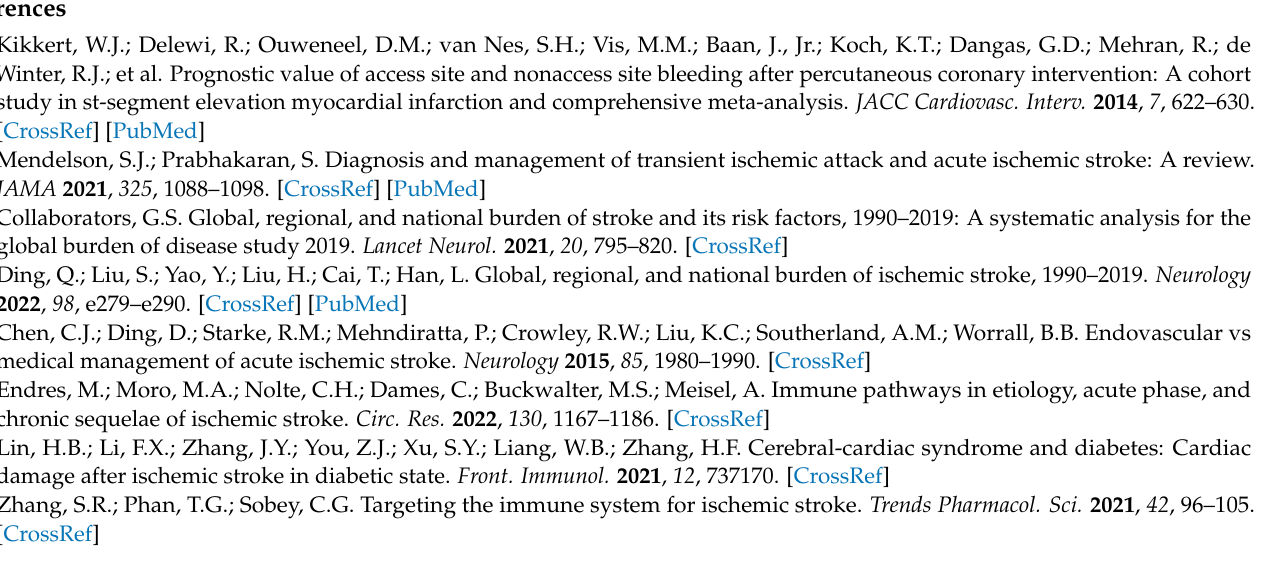
stain; Figure S2: Infarct volume of ischemic area; Table S1: Triphenyltetrazolium chloride staining ( n = 5); Table S2: Neurological deflict score ( n = 9); Table S3: Body weight ( n = 7–8); Table S4: The counts of exhaustion ( n = 6); Table S5: Moving distance ( n = 5–6); Table S6: Pull strength ( n = 6–9); Table S7: Muscle electrical signal intensity (n=4–5); Table S8: Soleus weight and soleus length ( n = 5); Table S9: Muscle cross section ( n = 5–6); Table S10: Sarcomere length ( n = 44–47); Table S11: JC-1 ratio of red to green fluorescence ( n = 4–6); Table S12: The protein expression of Drp1 and mitofusin 2 ( n = 5); Table S13: LC3B positive cell ratio and p62 positive cell ratio ( n = 5); Table S14: Protein expression related to autophagic process ( n =